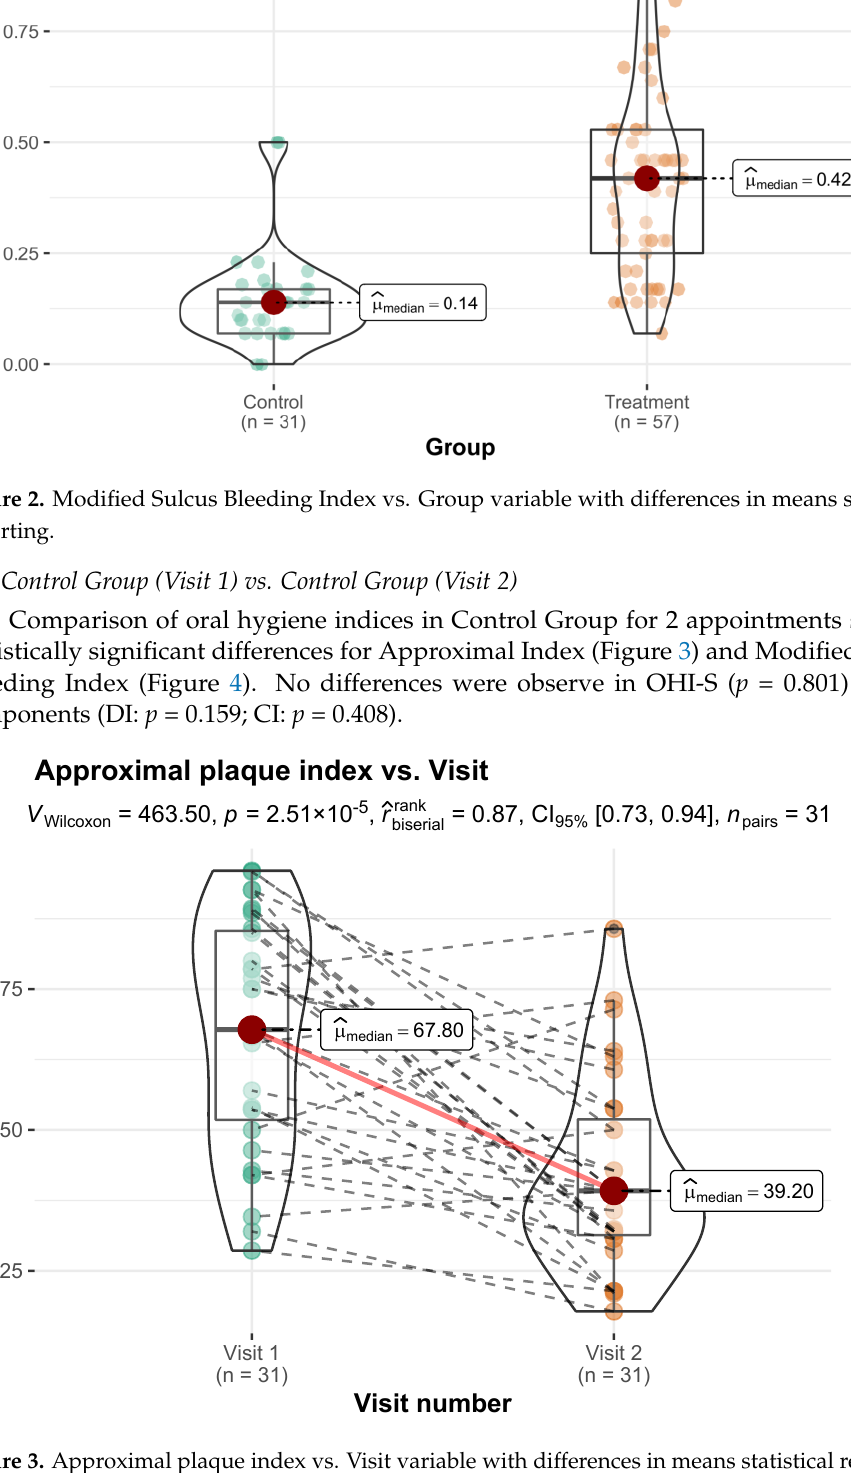
Figure 3. Approximal plaque index vs. Visit variable with differences in means statistical reporting.